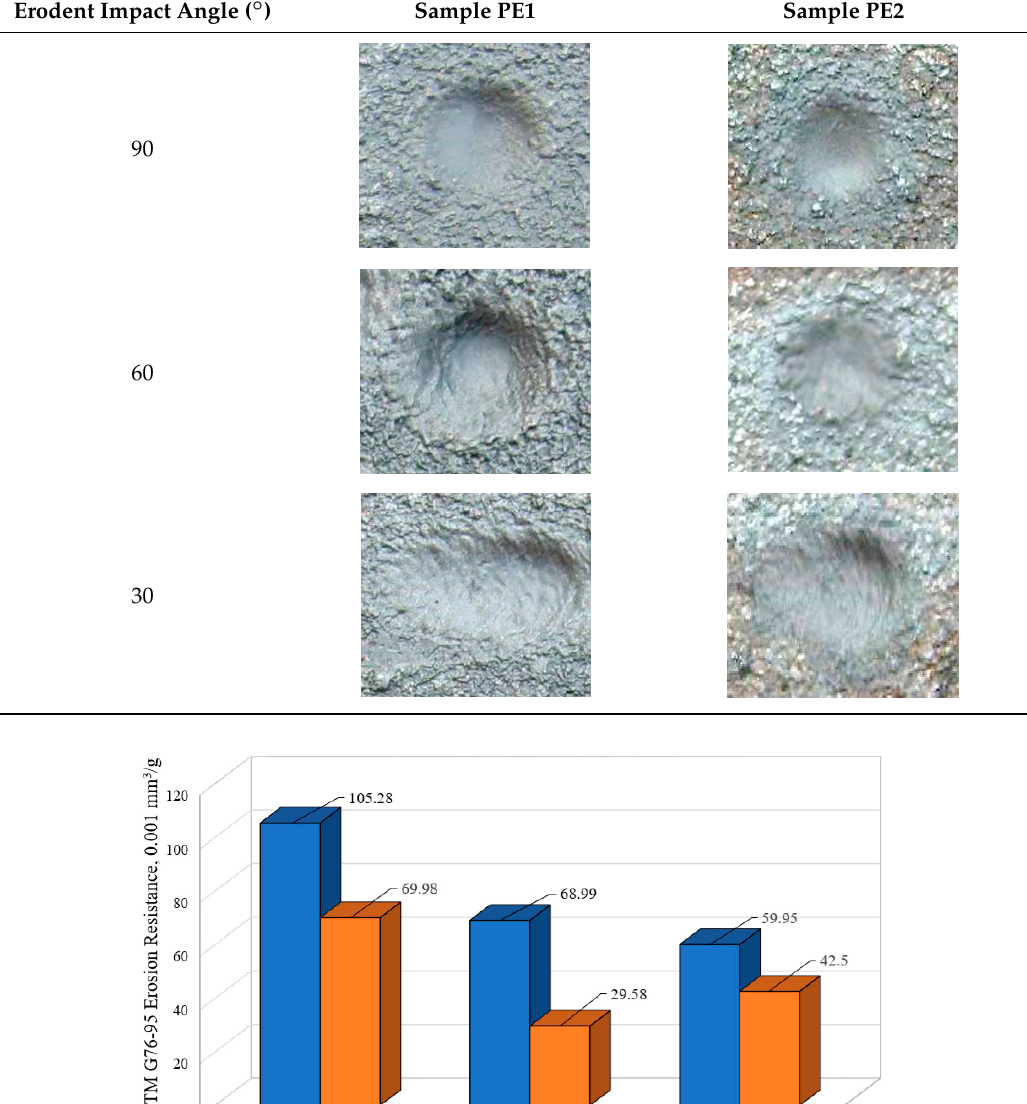
Figure 7. Results of erosion resistance tests for investigated materials and different erodent impact angles. Table 4. PE1 and PE2 samples after erosion test, comparison of erodent effect on the sample surfaces for each of the angles studied.